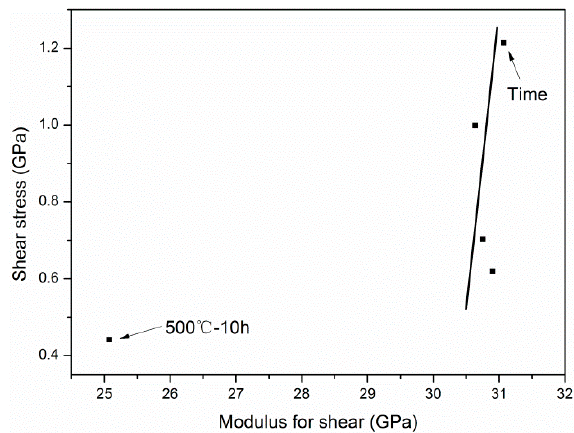
Figure 21. The dependence of the exposure time on the relationship between the modulus for shear and the shear strength between the graphite layers.